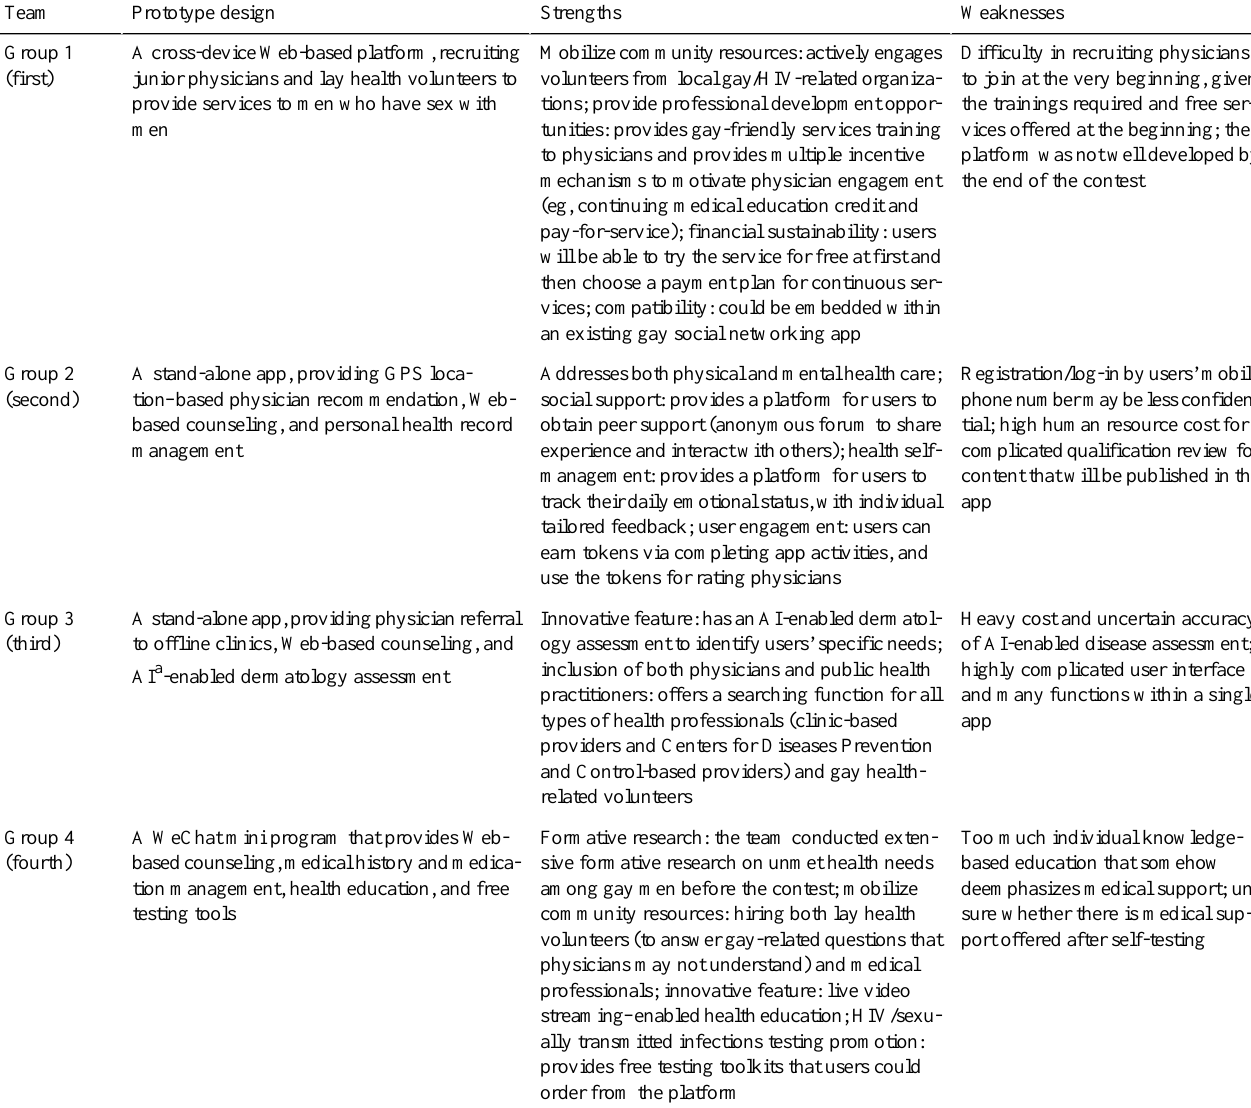
Table 2. Awarded prototypes developed during the hackathon and their strengths and weaknesses identified by the judge panel. WeaknessesStrengthsPrototype